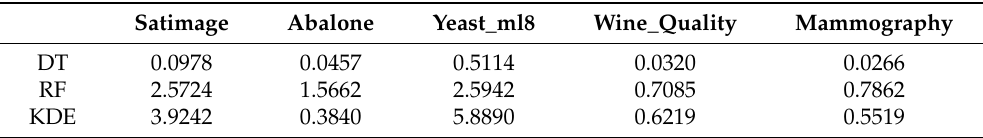
Table 5. Execution times (in s) on the real-life